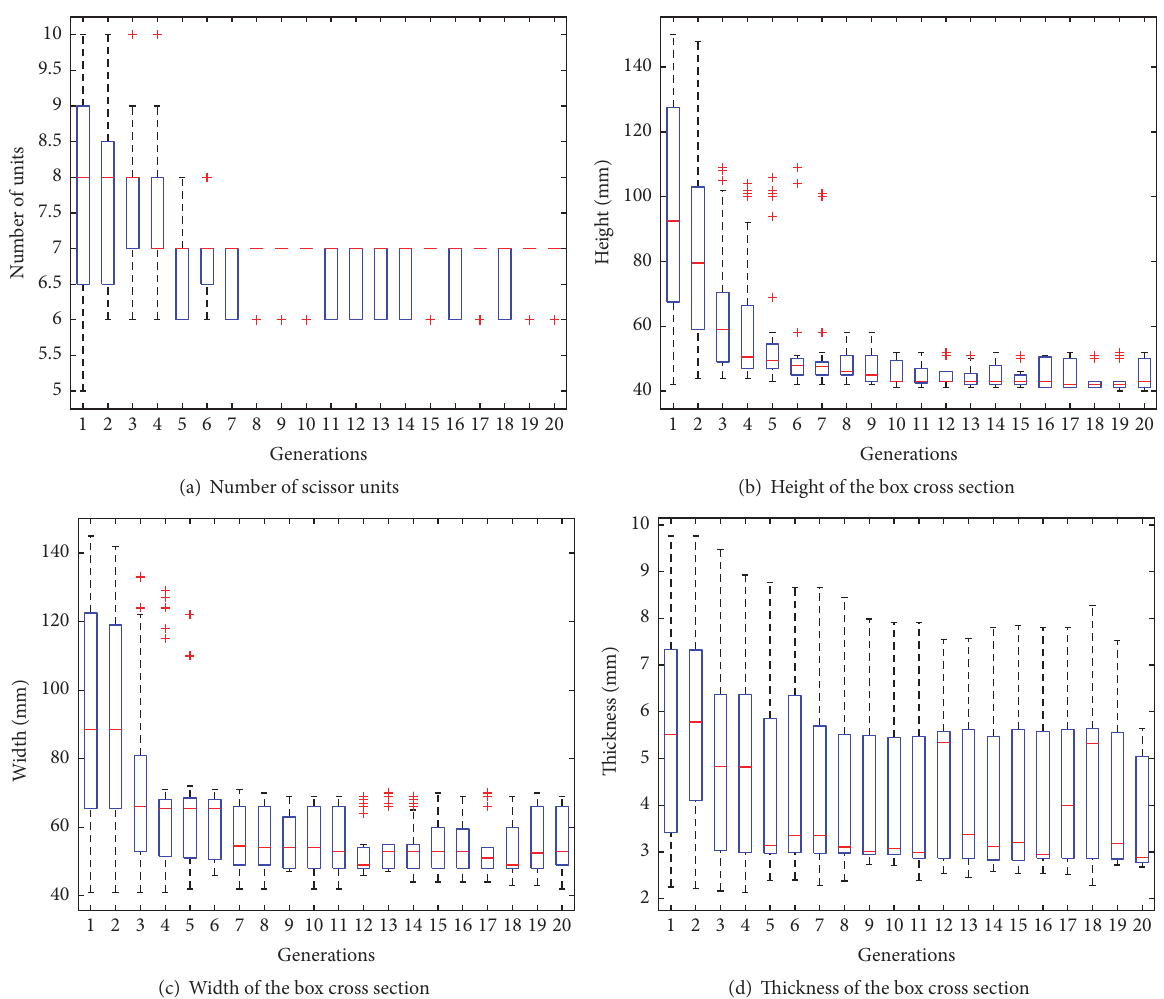
Figure 8: (a) shows that the number of units is optimal at 7. The three other design variables are evolving to the bottom side showing that the simulation is reducing the cross-sectional dimensions in order to obtain better solutions in the Pareto